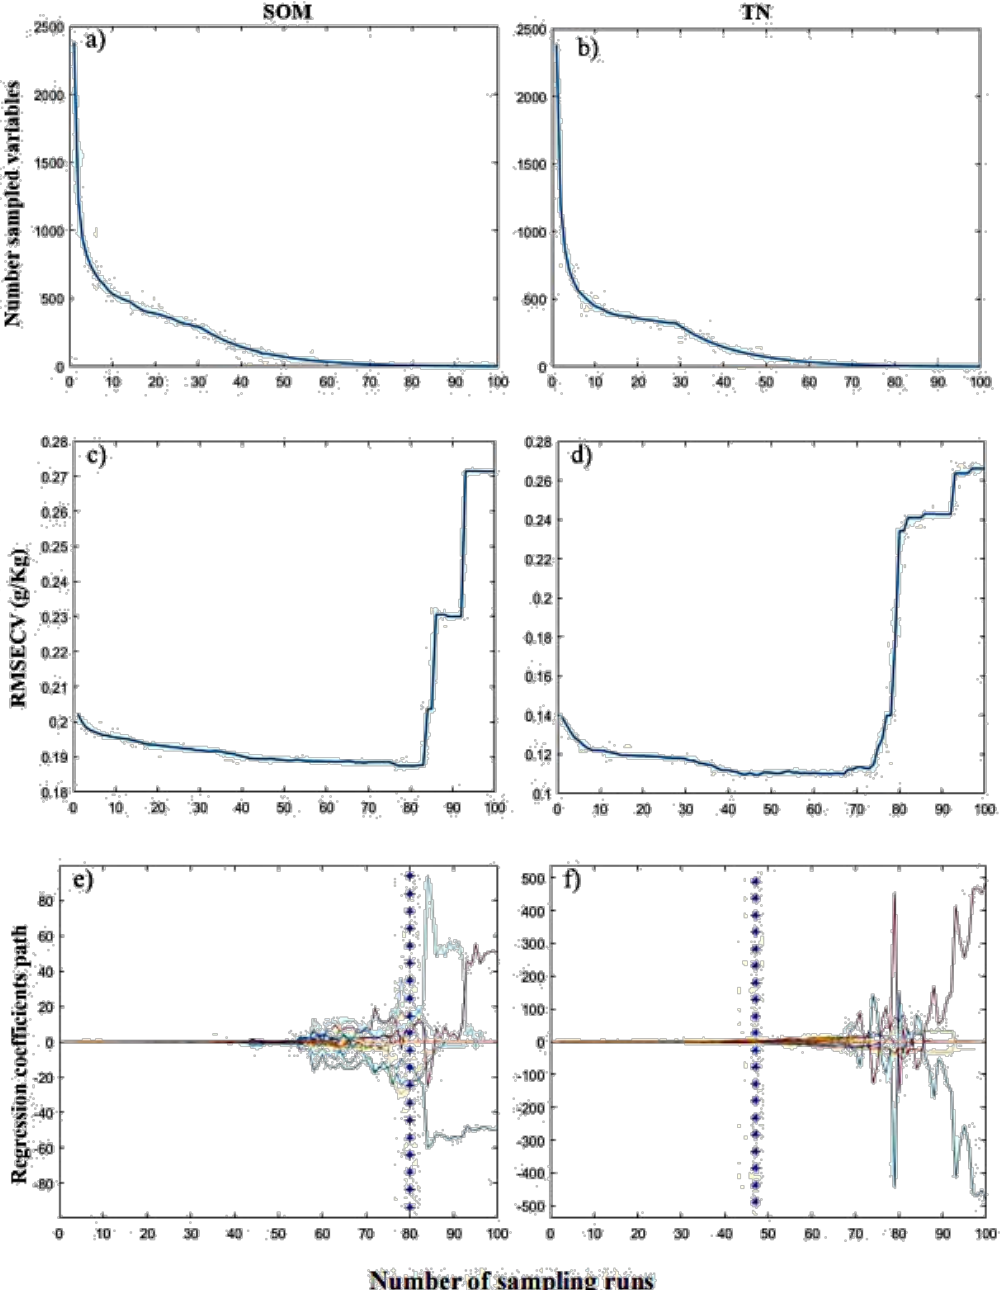
Figure 7. Variable selection of soil MIR spectra for SOM and TN prediction based on sCARS method. Note: ( a , b ) number of selected variables; ( c , d ) values of ten – fold cross-validation; ( e , f ) regression coefficient path of each variable. Vertical line with asterisks: where the optimal subset corresponded to the lowest RMSECV.